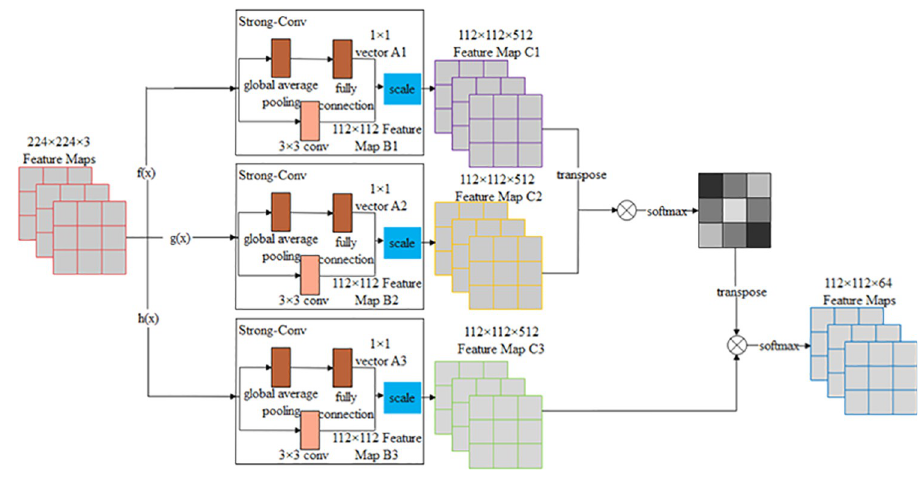
Fig 4. Structure of